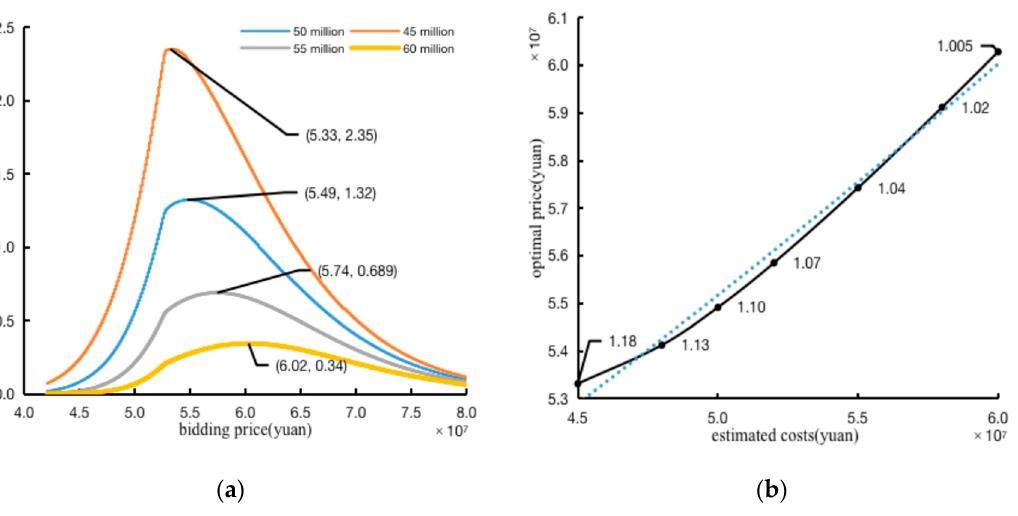
Figure 6. Sensitivity analysis of the estimated costs. ( a ) Costs sensitivity; ( b ) Fluctuation trend of optimal price. ( b = 10; n = 1.1; u = 0.3; r = 0.01; σ = 0.2 ; T-t = 0.5; N = 50; AP comps = 52.79 million).